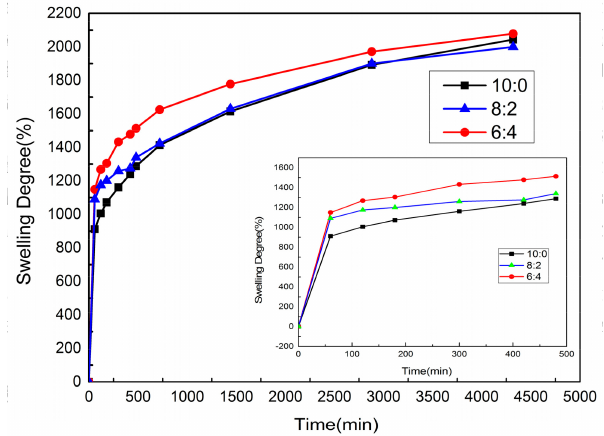
Figure 3. The swelling ratios of P-CH hydrogel with di ff erent